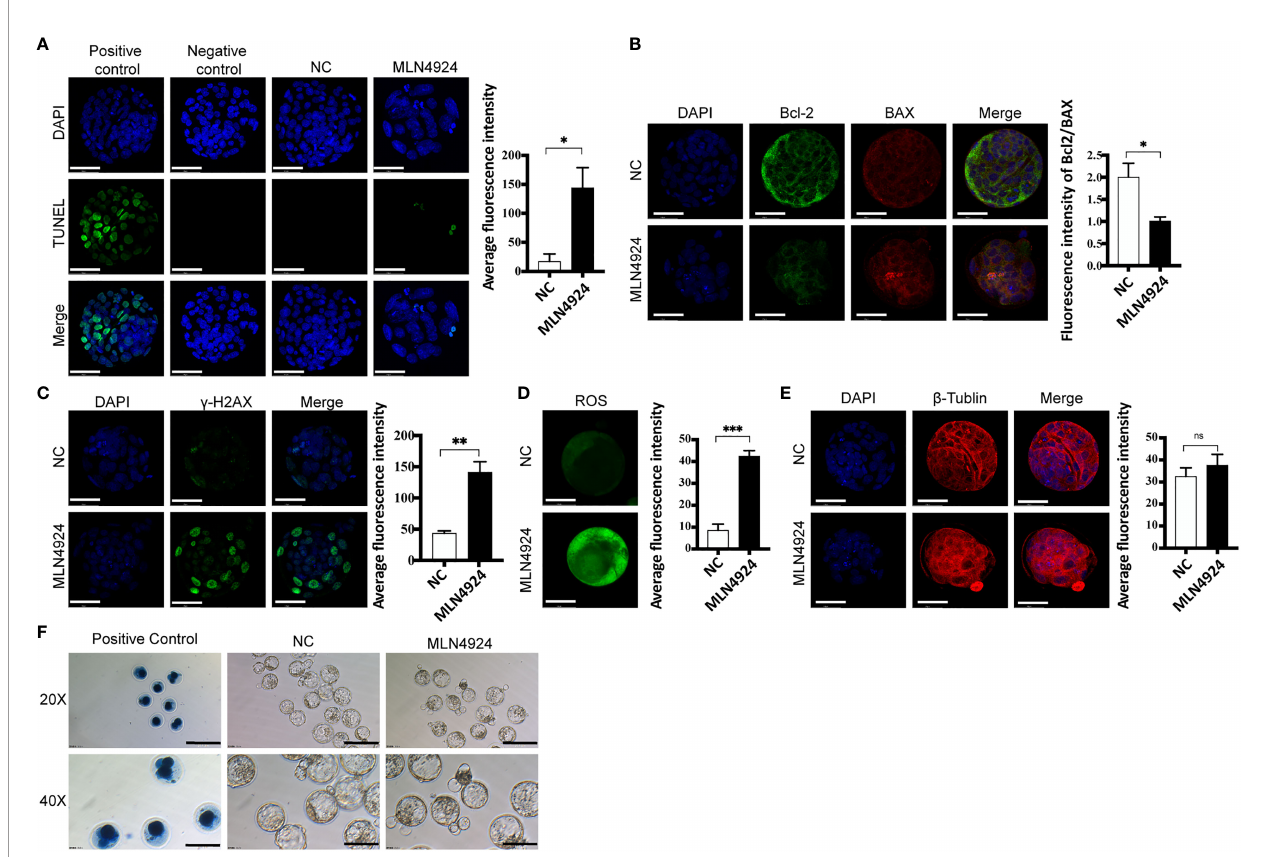
FIGURE 3 | Neddylation block elevated oxidative stress in blastocysts. (A) TUNEL assay detecting late cell apoptosis in NC (n = 30) and MLN4924-treated blastocysts (n = 30). Positive control: blastocyst treated with DNase I Negative control: blastocyst without TdT enzyme. The signal intensities were increased in MLN4924-treated blastocysts comparing with NC. Scale bar for immuno fl uorescence image is 50 m m. (B) Immuno fl uorescence of Bcl-2 and BAX (Bcl2 Associated X Protein) in NC (n = 30) and 2 m M MLN4924-treated blastocysts (n = 30). Green stained blastocysts represent Bcl-2, red-stained blastocysts represent Bax. The histogram is the fl uorescence intensity ratio of Bcl 2 and BAX, the ratio of the control group was higher than that of the MLN4924-treated blastocysts. (C) Immuno fl uorescence was used to capture representative g H2AX focus images from NC (n = 30) and MLN4924-treated blastocysts (n = 30). Increasing fl uorescence intensity was detected in the MLN4924. (D) ROS (Reactive Oxygen Species) assay evaluating mitochondrial function in NC (n = 30) and MLN4924- treated group (n = 30). The cell localization changed and fl uorescence signal intensities were increased in MLN4924-treated blastocysts compared with NC. (E) Intensity of b -tubulin (red) immuno fl uorescence re fl ecting cytoskeleton function. The fl uorescence signal intensities showed no signi fi cant difference in MLN4924- treated blastocysts (n = 30) compared with NC (n = 30). (F) Cell viability tested with Trypan blue staining. Dead cells were stained with blue, showing in PC. Both NC (n = 60) and MLN4924-treated blastocysts (n = 60) were viable. Scale bar for bright fi led image is 200 m